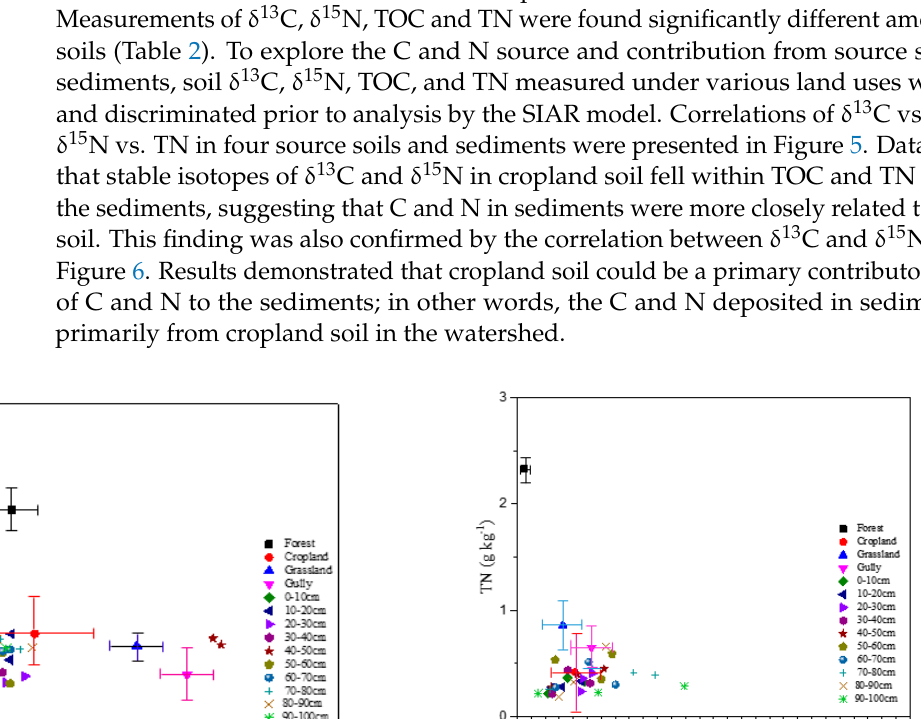
Figure 5. Correlations of TOC vs. δ 13 C and TN vs. δ 15 N in the source soils and sediments (Horizontal and vertical bars denote 95% confidence intervals).